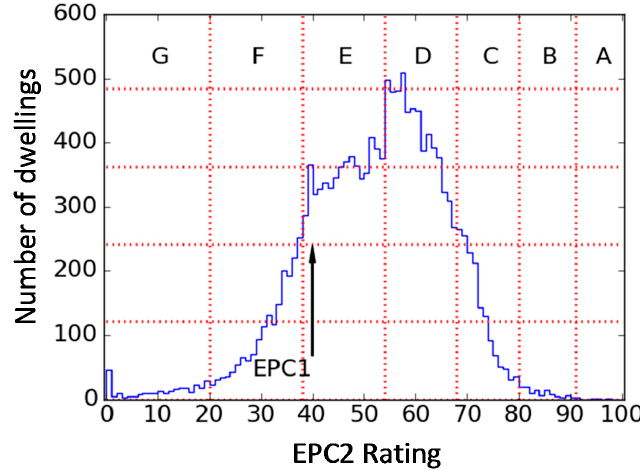
Figure 11. Second EPCs for dwellings with a first EPC of 40. Distribution shows a spike at exactly 40 and a step change at the D/E band boundary.